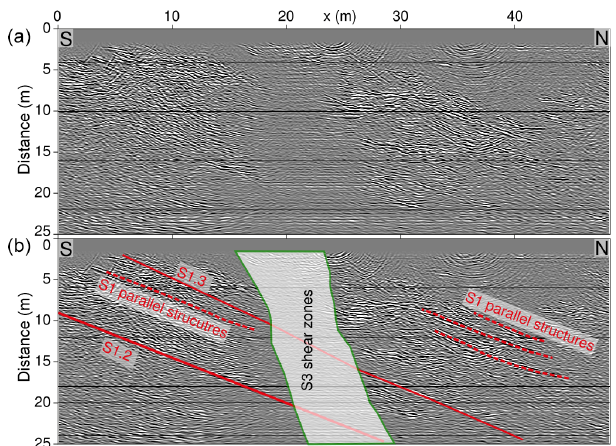
Figure 7. Fully processed and migrated GPR data acquired from the VE tunnel, along with its geological interpretation. Panels (a) and (b) show the same GPR image. Additionally, in panel (b) , the inter- sections with the geological structures inferred from the geological model are shown. Here, especially the complex intersection zone of the S1 and S3 shear zones is of